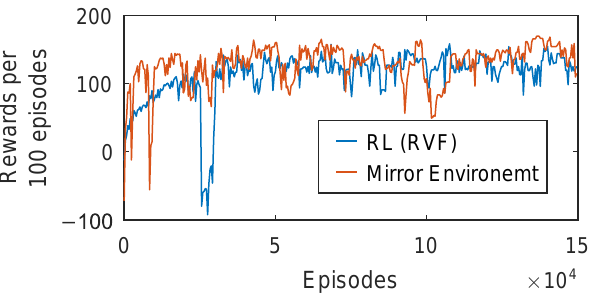
Figure 4. Reward plot over the training episodes. Proposed agent can learn to localize both folds in a similar time the usual agent learns a single fold.